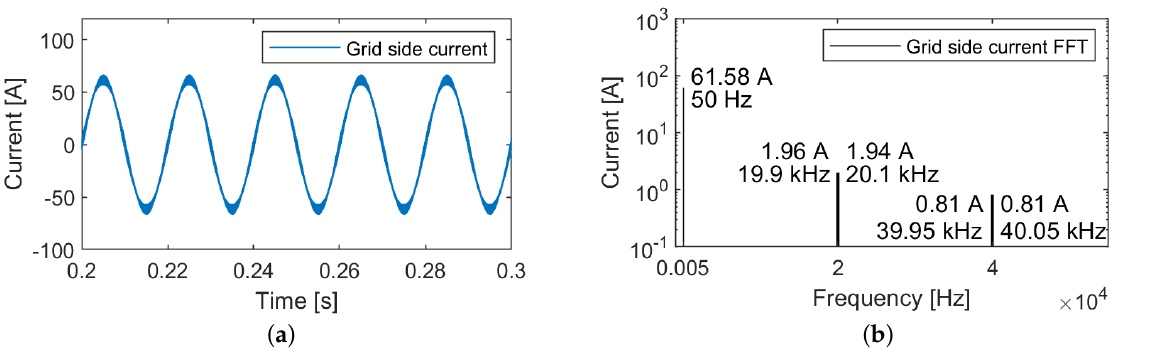
Figure 9. Two-level six-switch boost-type rectifier simulation results. ( a ) Grid side current. ( b ) Grid side current harmonic analysis.